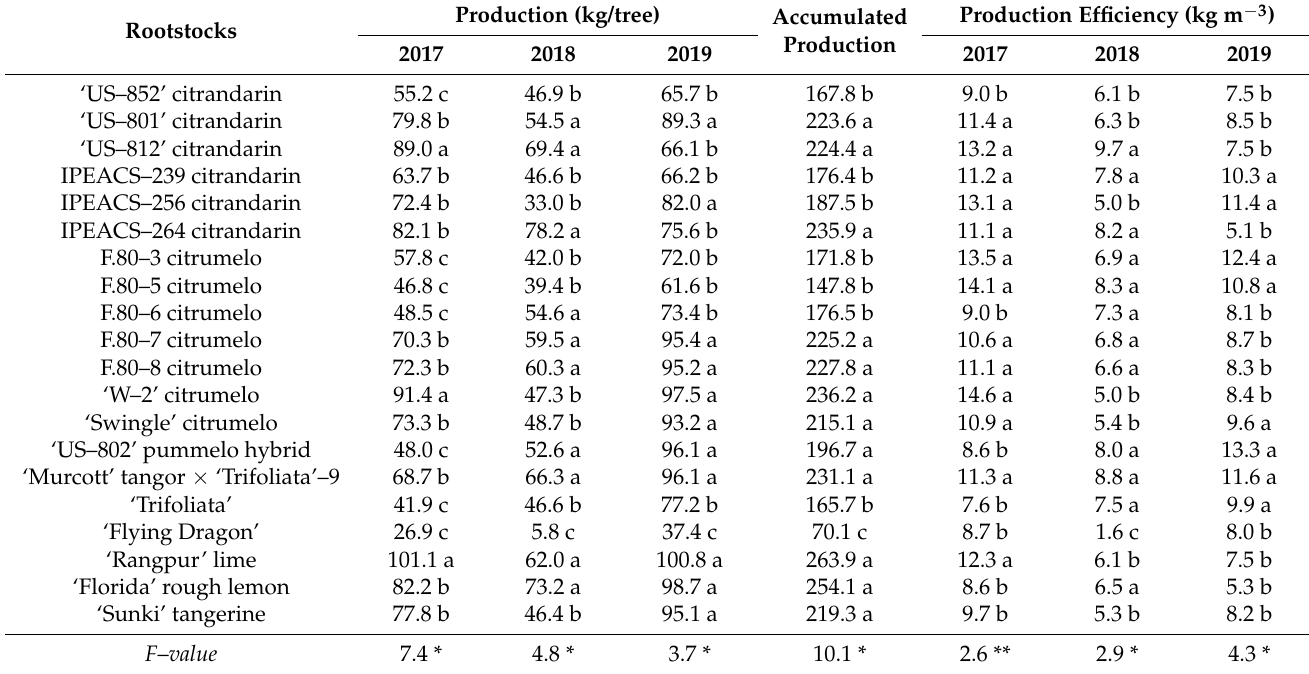
Table 3. Production of ‘Valencia’ sweet orange trees grafted on 20